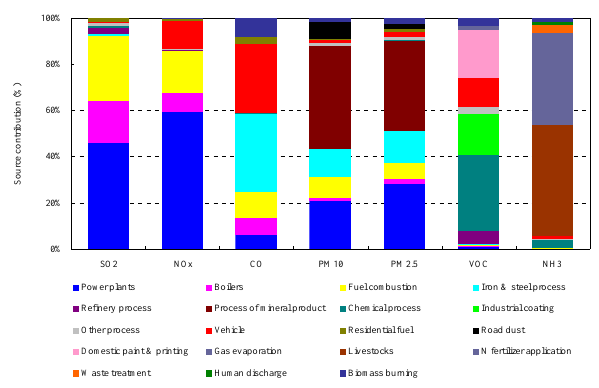
Fig. 3. Emission contribution of source categories in the YRD region in 2007.